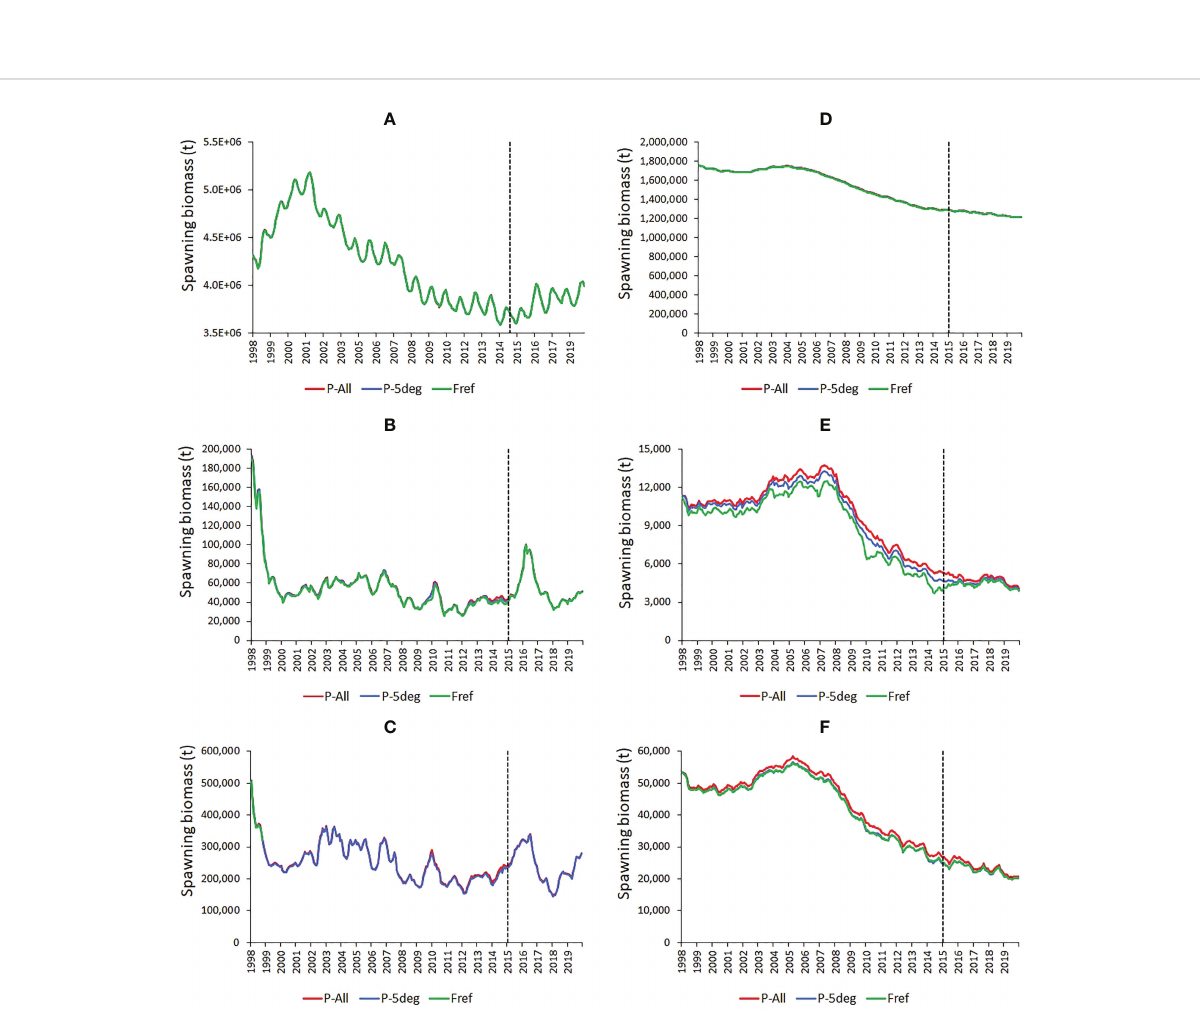
FIGURE 6 Time series of estimated change in skipjack (A-C) and bigeye (D-F) tuna spawning biomass ( SB ) for the observed fi shing activity (Fref) and for retrospective PIPA closures under two catch/effort redistribution assumptions (P-All and P-5deg) in the western and central Paci fi c Ocean (A, D) , in the PIPA (B, E) and in the PIPA fi ve-degree spill-over area (C, F) . The vertical dashed lines indicate the implementation of the actual PIPA